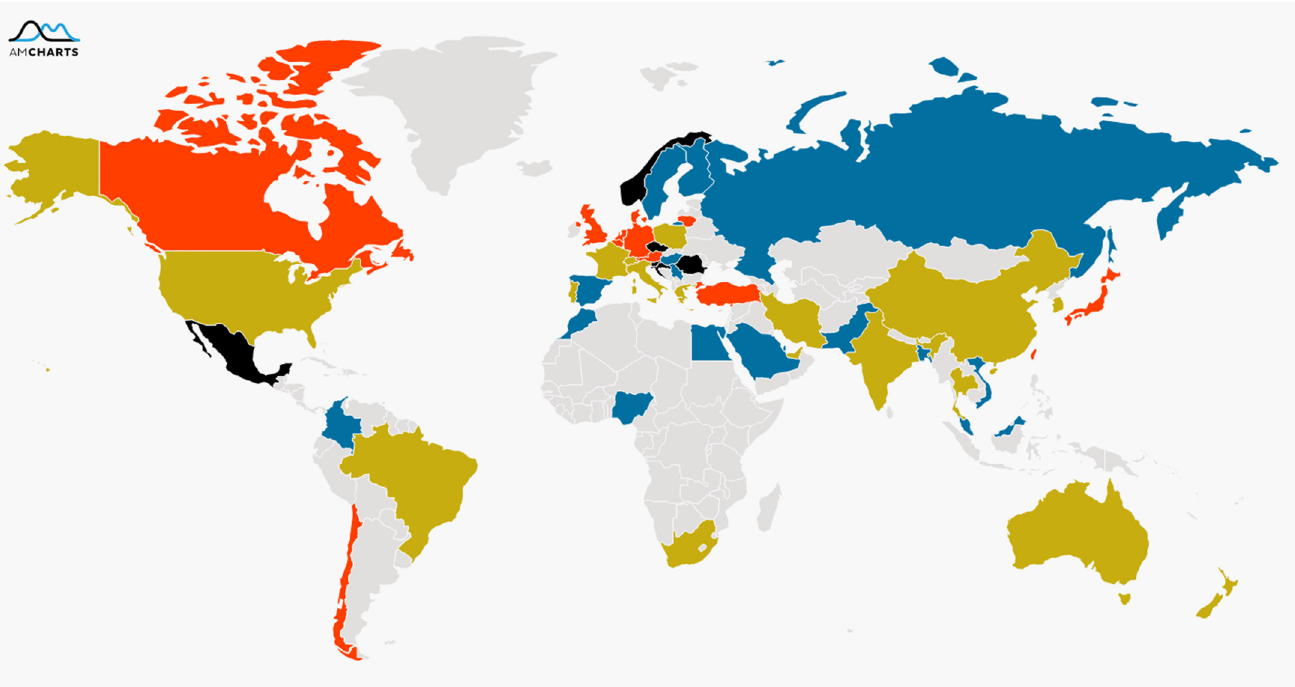
Figure 3. Academic efficiency map. Red: CpD > 30. Yellow: 20 < CpD < 30. Blue: 10 < CpD < 20. Black: CpD < 10. Source: Authors’ elaboration with AMCharts.